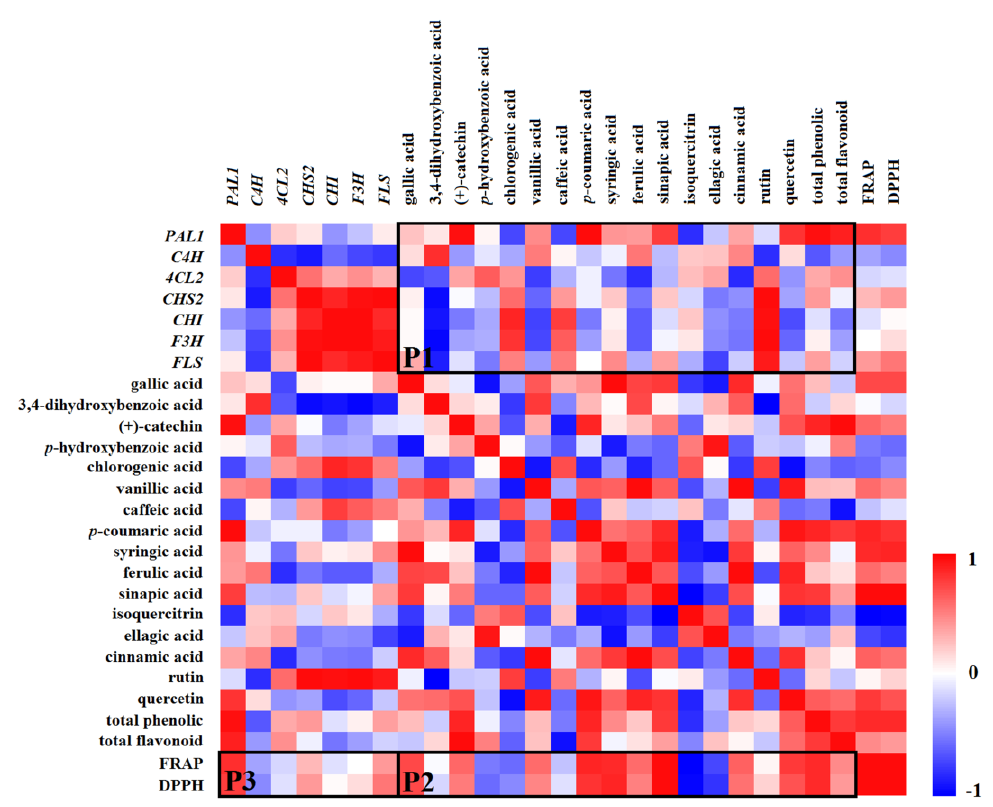
Figure 9. E ff ect of ABA on correlations between gene expression, phenolic compounds, and antioxidant capacities. The heatmap was produced based on obtained Pearson’s correlation coe ffi cients with the relative levels of all indexes in ABA-treated fruits (the levels in control fruits were all normalized to one) on days 1, 7, 11, and 15. The red ( + 1) and blue ( − 1) colours represent the positive and negative correlations, respectively, between di ff erent indexes. (For interpretation of the references to colour in the Figure 9 legend, the reader is referred to the web version of this article.)